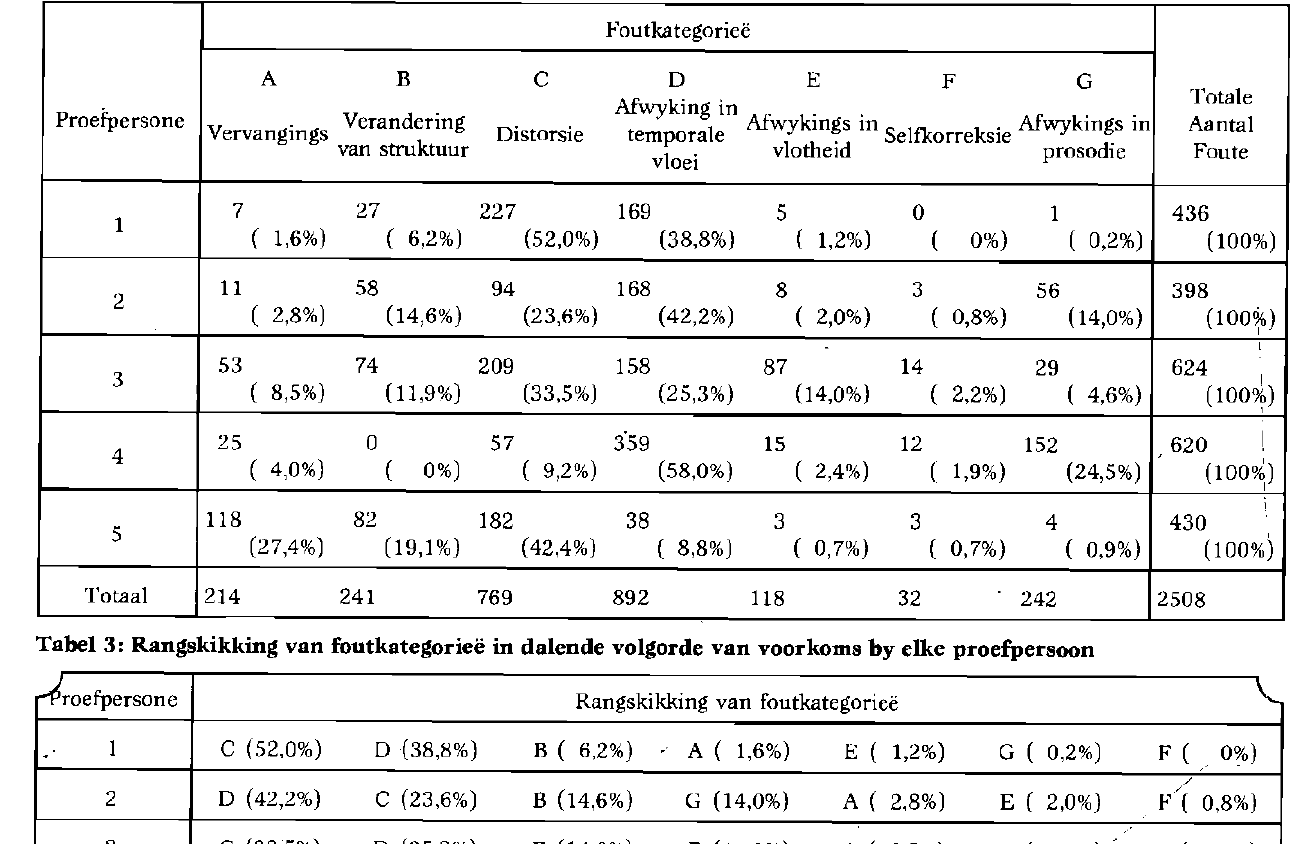
Tabel 2: Die frekwensie (en persentasie) van voorkoms van die foutkategoriee by elke proefpersoon.